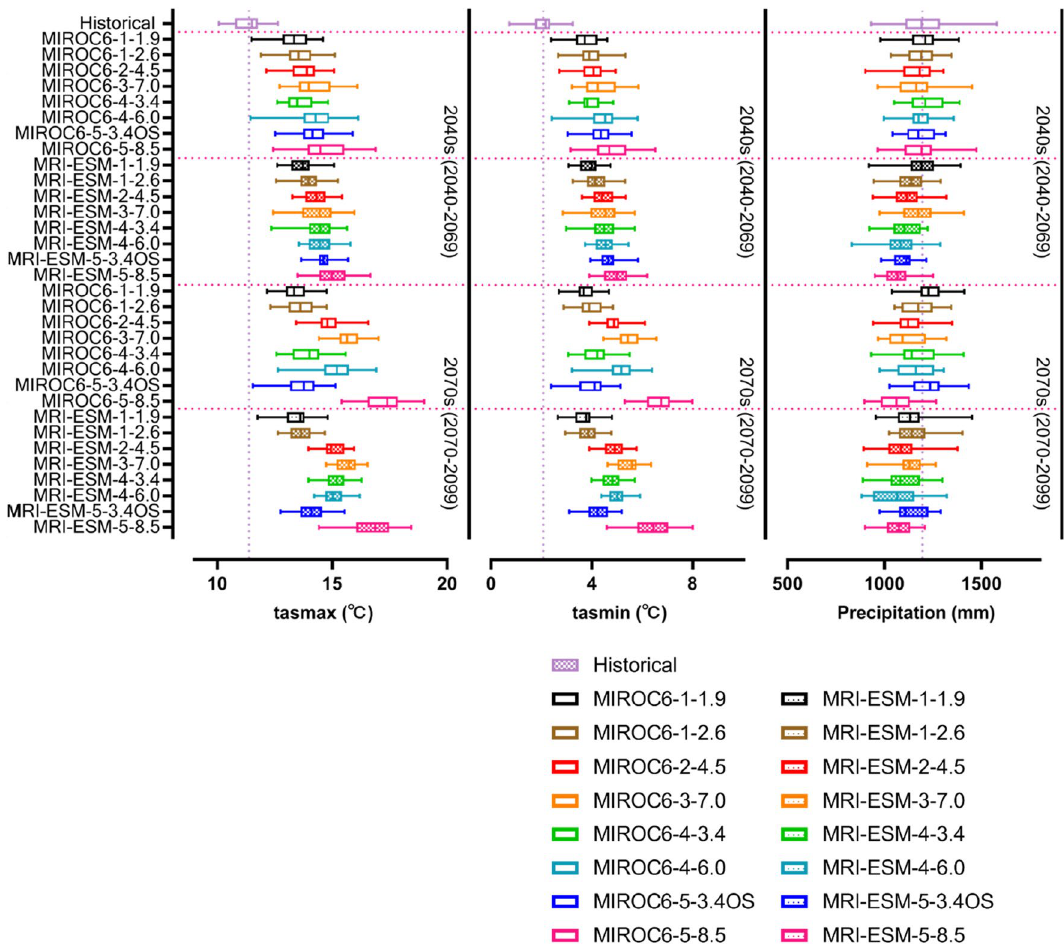
Figure 8. Variations in maximum temperature (tasmax), minimum temperature (tasmin), and precipitation in periods of the 2040s and 2070s under SSP-RCPs scenarios of MIROC6 and